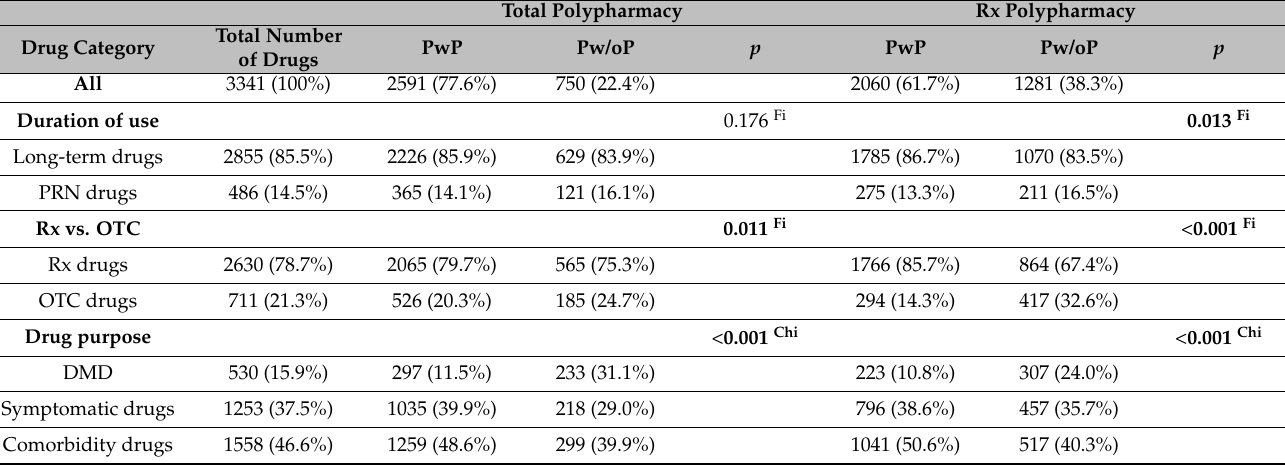
Table 2. Total number of all recorded medications (counted with repetitions), subdivided by drug category and polypharmacy status of the patients with MS (N =